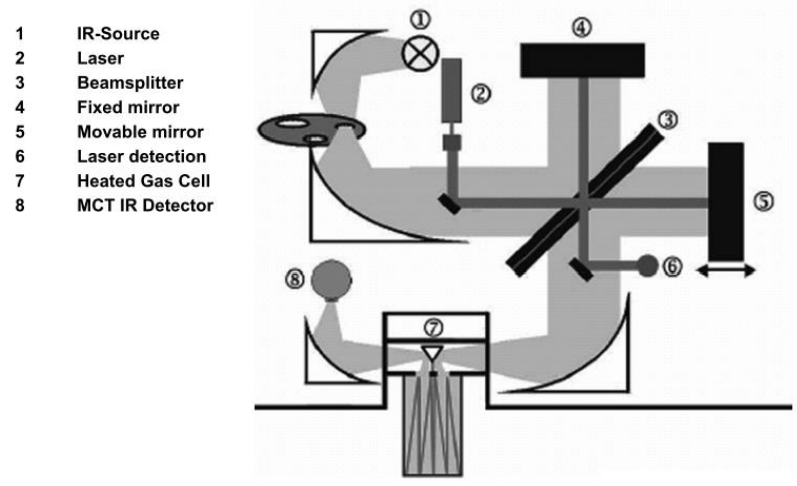
Figure 3. The spectrometer bench setup [11].